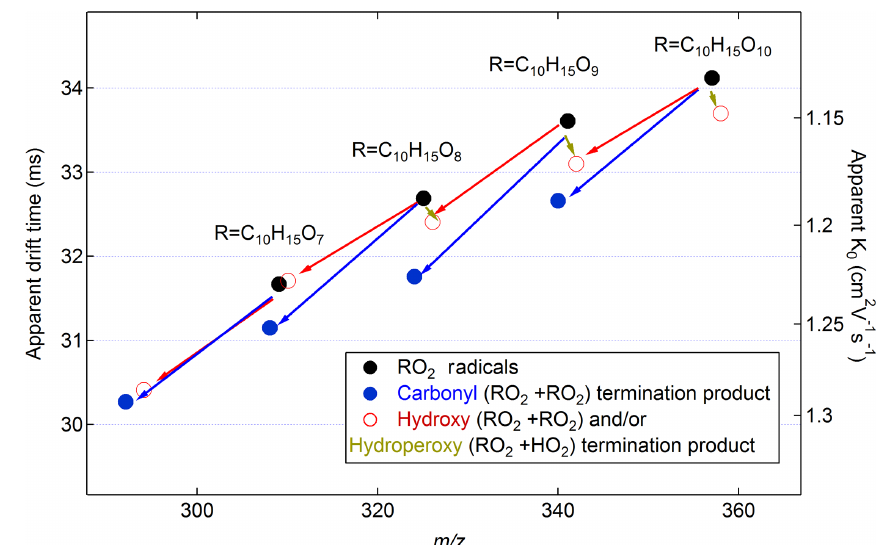
Figure 9. 2-D IMS–MS plot of select extracted masses from ambient SOAS NO 3 -IMS–MS data. Peroxy radicals (C 10 H 15 O x , where x = 7– 10) are presented in 2-D space, along with their hydroperoxy (-OOH; C 10 H 16 O x ) , hydroxy (-OH; C 10 H 16 O x − 1 ) , and carbonyl ( = O; C 10 H 14 O x − 1 ) termination products, as identified in Mentel et al. (2015).